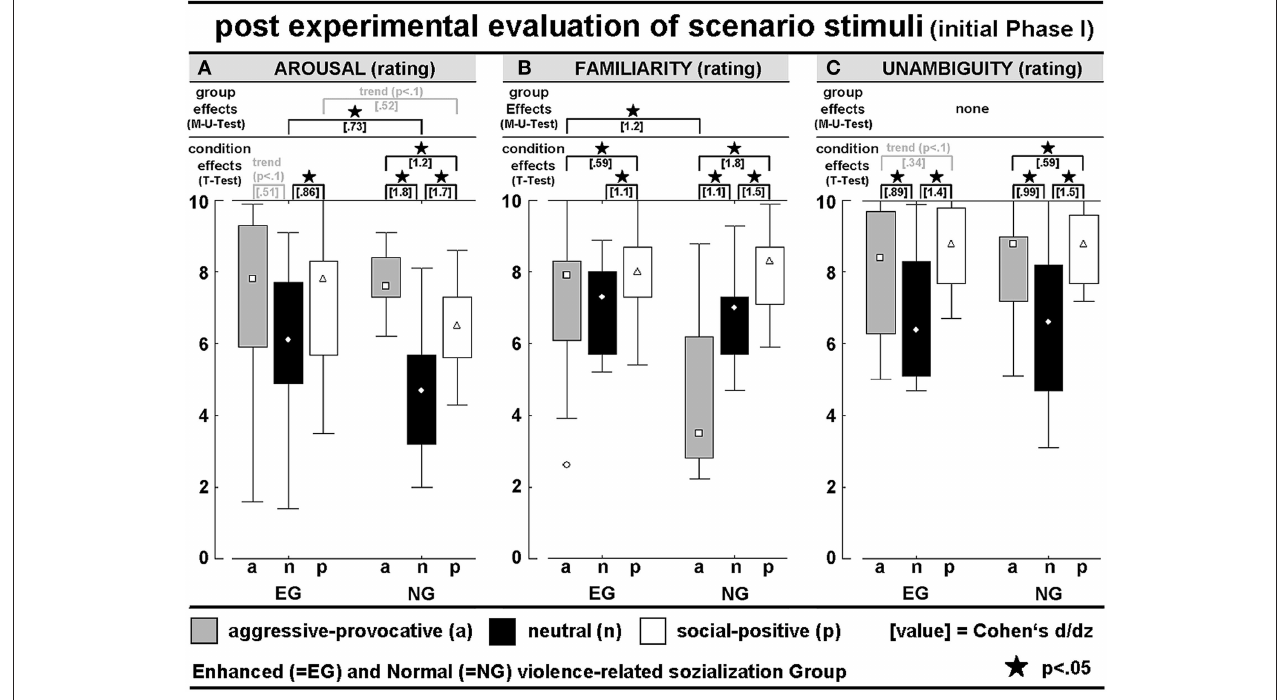
FIGURE 2 | Post hoc evaluation of PHASE I of the video clips concerning (A) interaction-related arousal, (B) interaction-related familiarity rating, and (C) interaction-related unambiguity rating; all scales had 11 levels (0–10); see Table 1 for detailed numerical information.